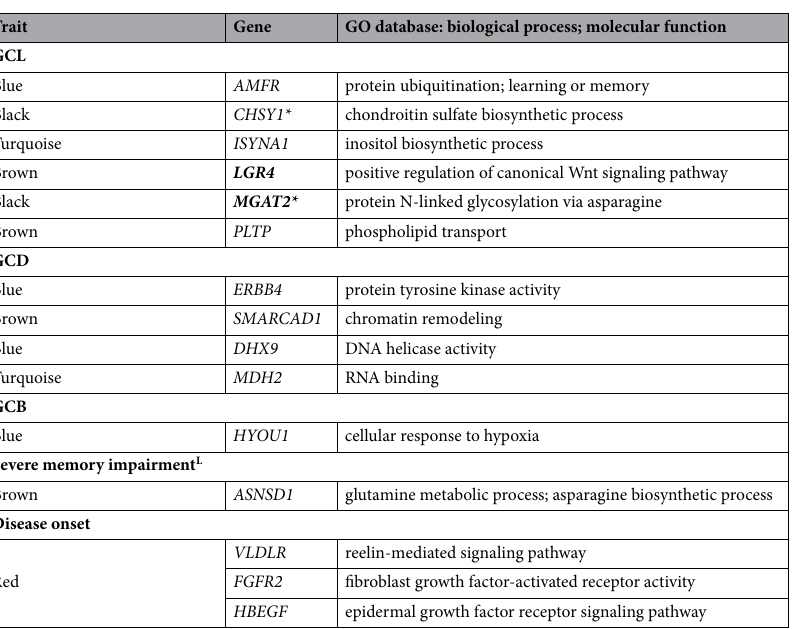
Table 2. HGS genes identified in modules associated with at least one trait: GCL, GCD, GCB, with severe memory impairment, or early/late disease onset. L Indicates LHS group; *Genes that presented highest GS and MM values; in bold genes that are also